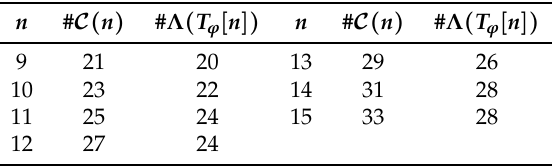
Table 1. n , # C ( n ) , and # Λ ( T ϕ [ n ]) for 8 < n ≤ 15 and ϕ =